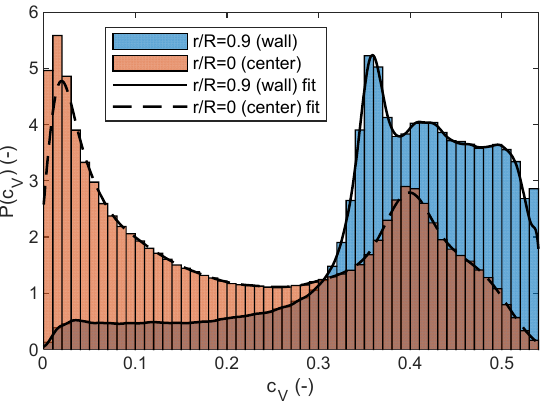
Figure 3. Probability density histograms at D = 0.1 m, H 0 = 0.2 m and U 0 = 0.7 m/s measured in the fluidized bed center (r/R = 0) and in the wall region (r/R = 0.9) with their fitted probability density distributions.